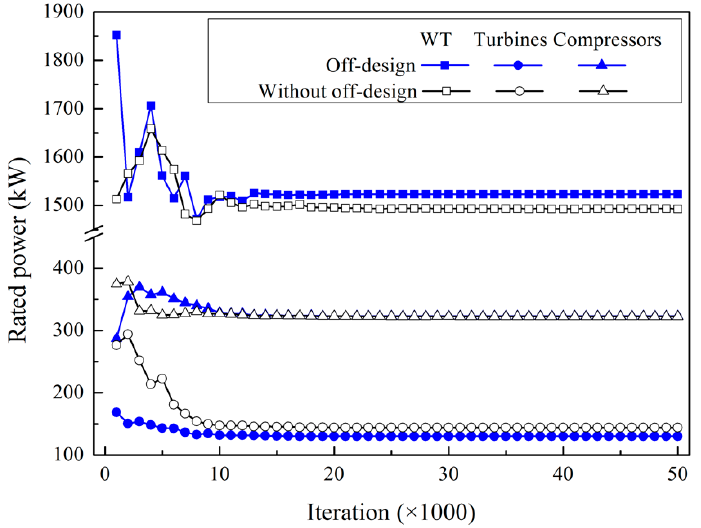
Figure 8. The optimization characteristics of the rated power in level I.